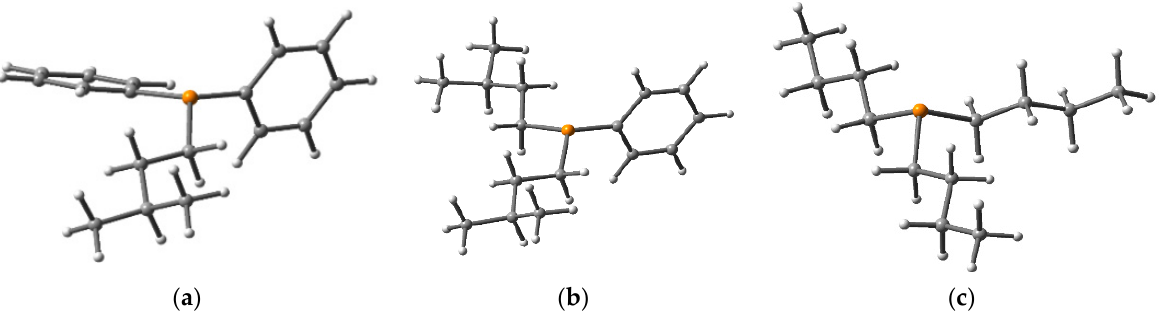
Figure 7. 3D optimized structures of ( a ) compound ( 5 ), ( b ) compound ( 10 ), and ( c ) compound tributylphosphine (PBu 3 ) from B3LYP calculations.